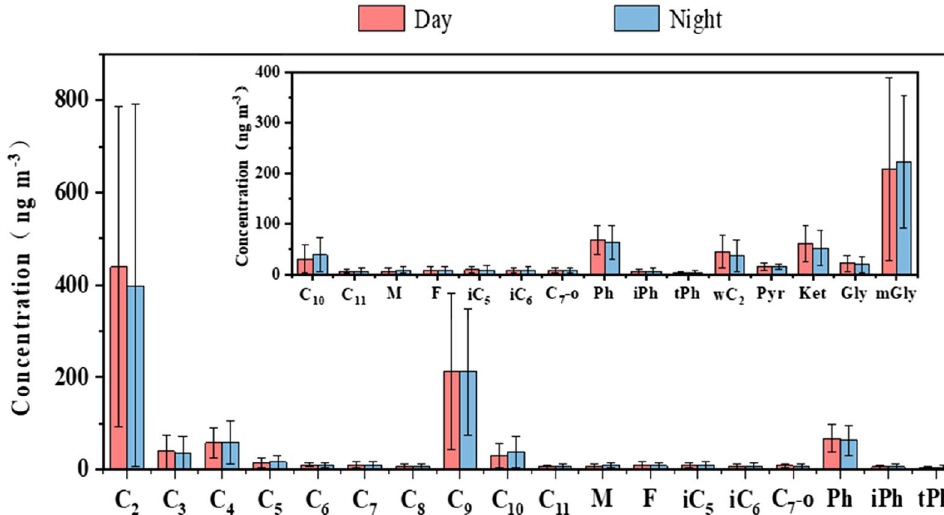
Figure 3. Molecular compositions of dicarboxylic acids and related compounds in PM 2.5 over Weinan.